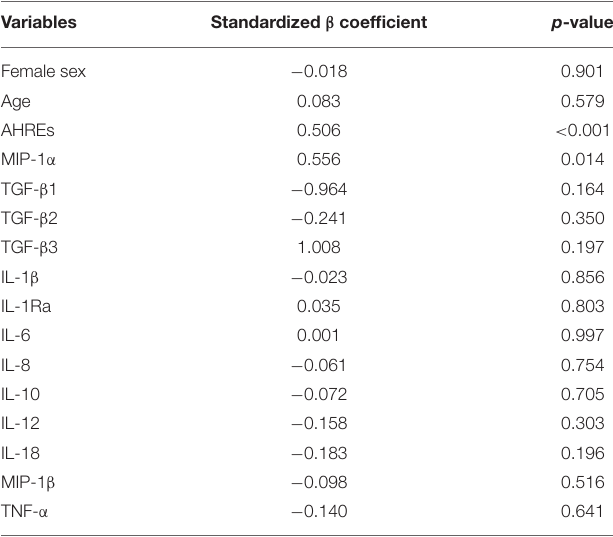
TABLE 3 | Multiple linear regression model predicting left atrial volume.